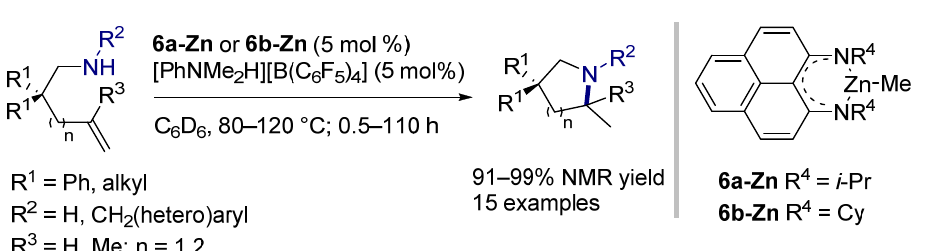
Figure 29. Intramolecular hydroamination of aminoalkenes catalyzed by phenalenyl-based organozinc complexes.